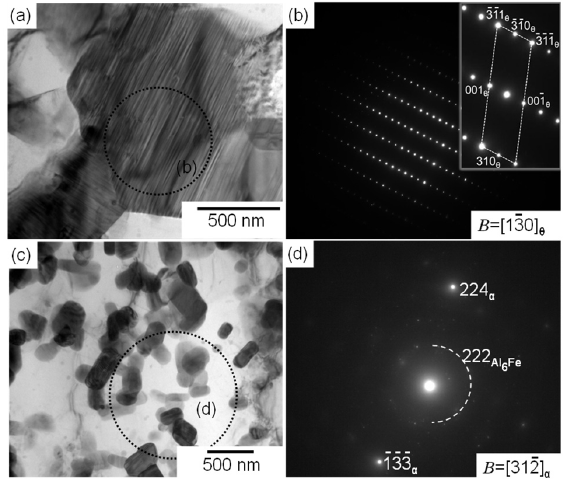
Figure 6. ( a , c ) Bright-field TEM images showing the intermetallic phases distributed in the melt pool and the corresponding ( b , d ) SAED patterns of an L-PBF-built Al–15%Fe alloy sample exposed to 500 °C for 100 h.